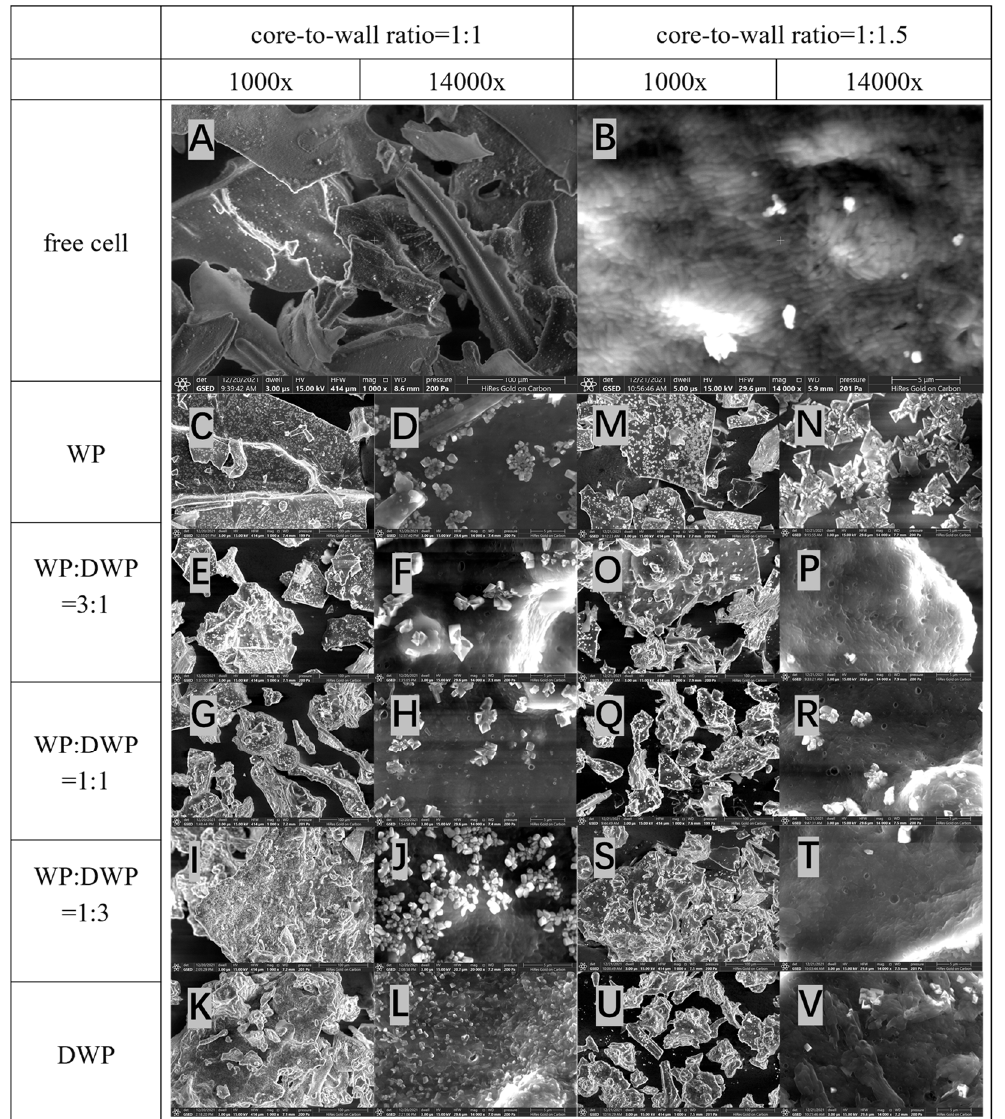
Figure 4. Scanning electron microscope (SEM) images of L. plantarum 299v cells under